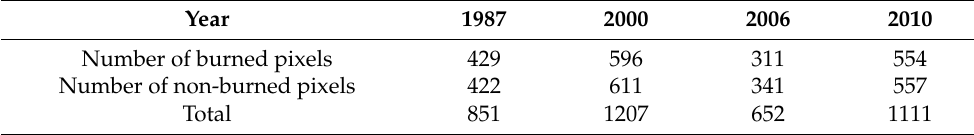
Table 1. The number of burned/non-burned pixels in 1987, 2000, 2006, and